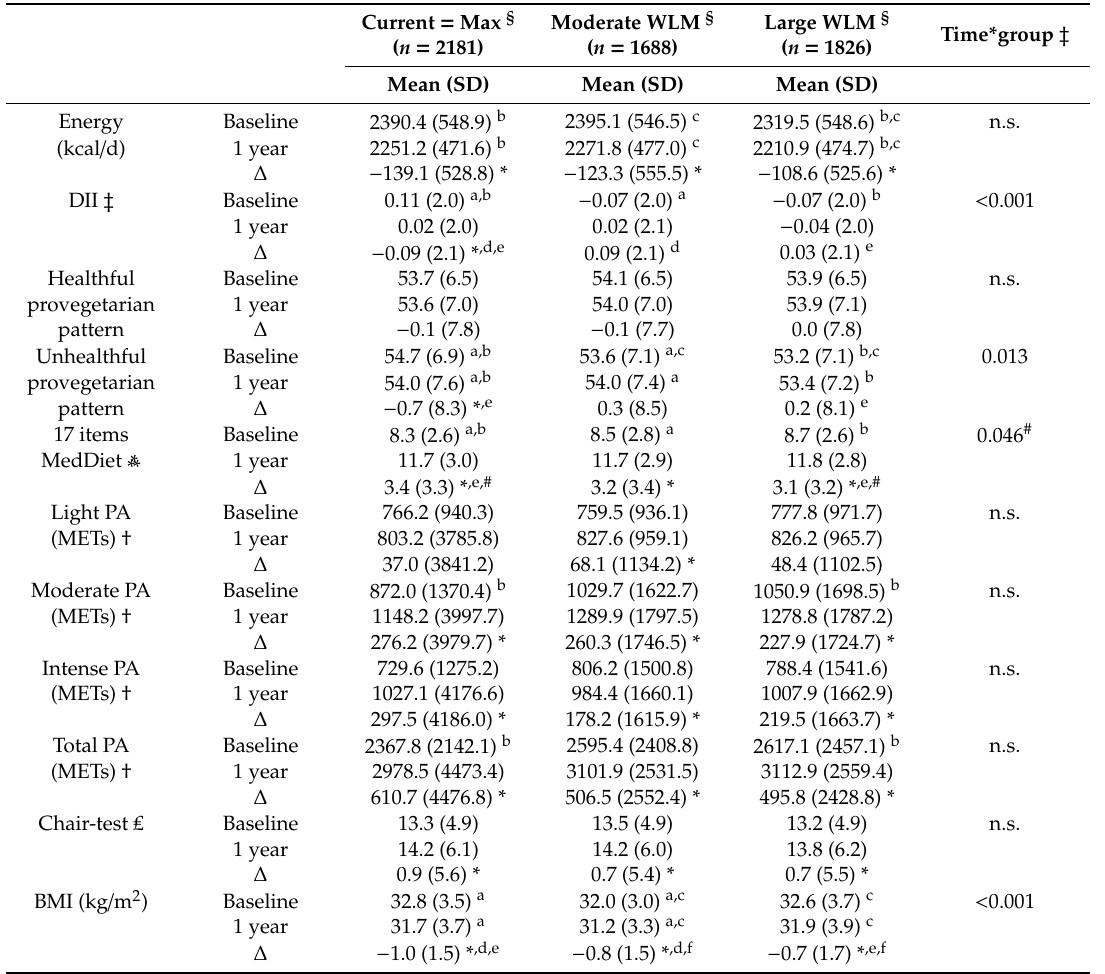
Table 2. Dietary patterns, physical activity pattern, and BMI changes according to maximum weight and BMI at